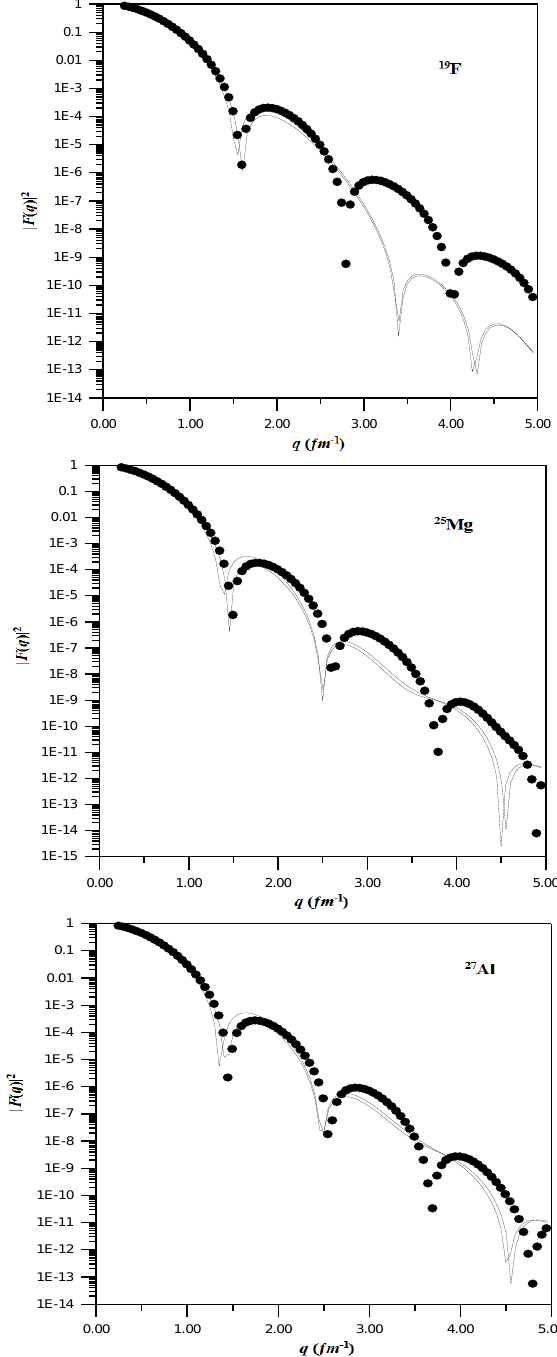
Fig.2: Dependence of the F (q) s on q (fm -1 ) for 19 F, 25 Mg and 27 Al nuclei. The dotted symbols are the experimental data of Ref. [20] for 19 F, 25 Mg and 27